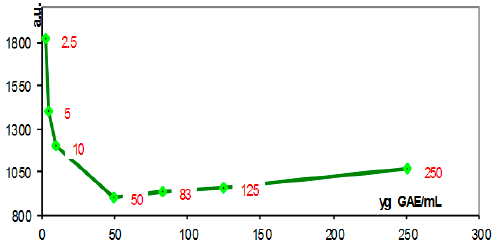
Figure 1. IC 50 assay on chokeberry fruit. Hot-assisted ethanolic extract.